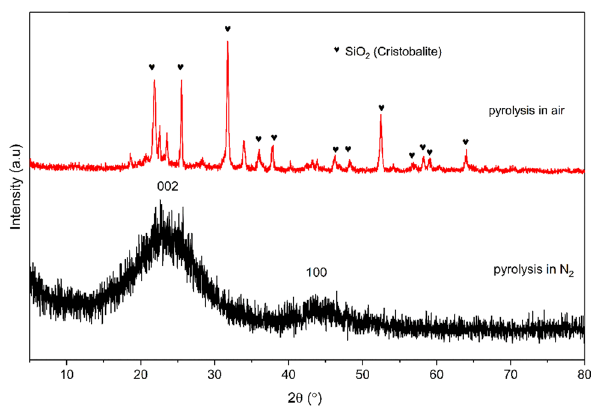
Figure 6: XRD patterns of cracking product of POSS - 8Phenol.